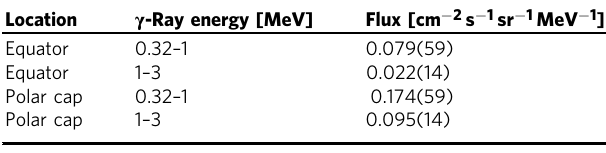
Table 1 Summary of total measured gamma-ray fl ux from the CORONAS-I satellite at 500 km altitude Location